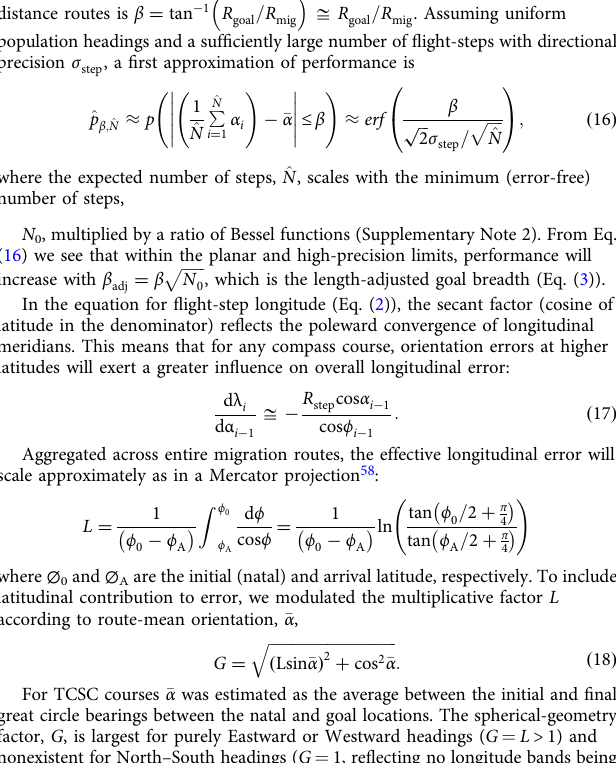
population headings and a suf fi ciently large number of fl ight-steps with directional precision